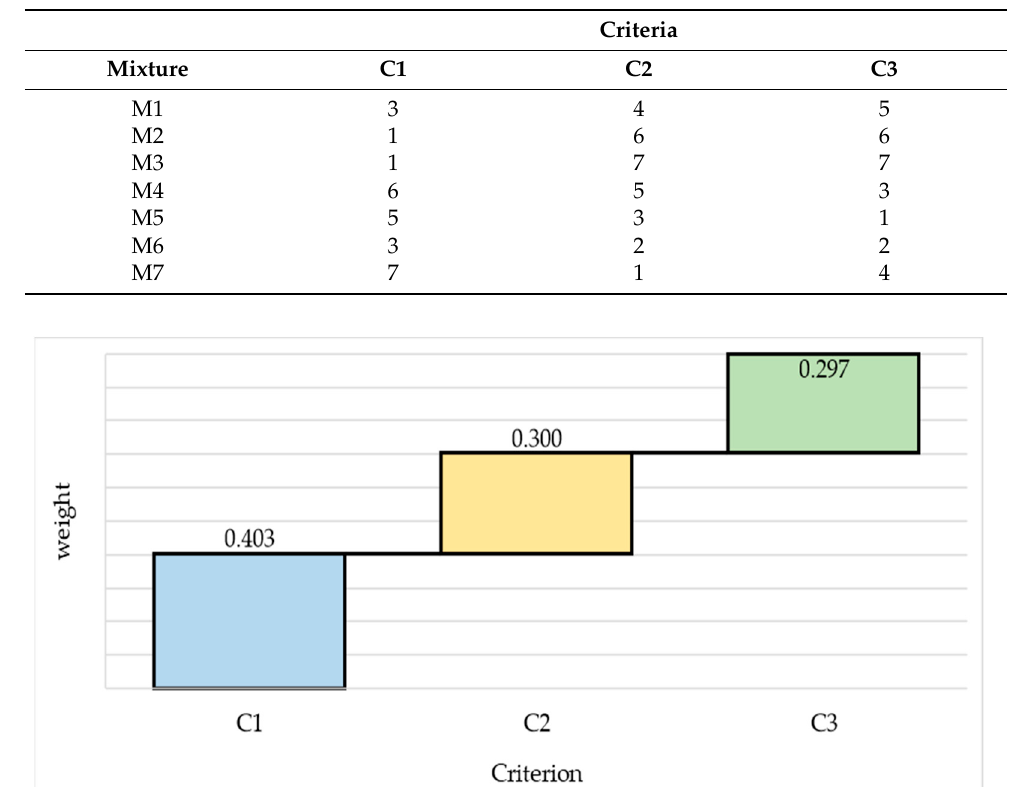
Table 12. Initial decision matrix in the MEREC-CoCoSo model.